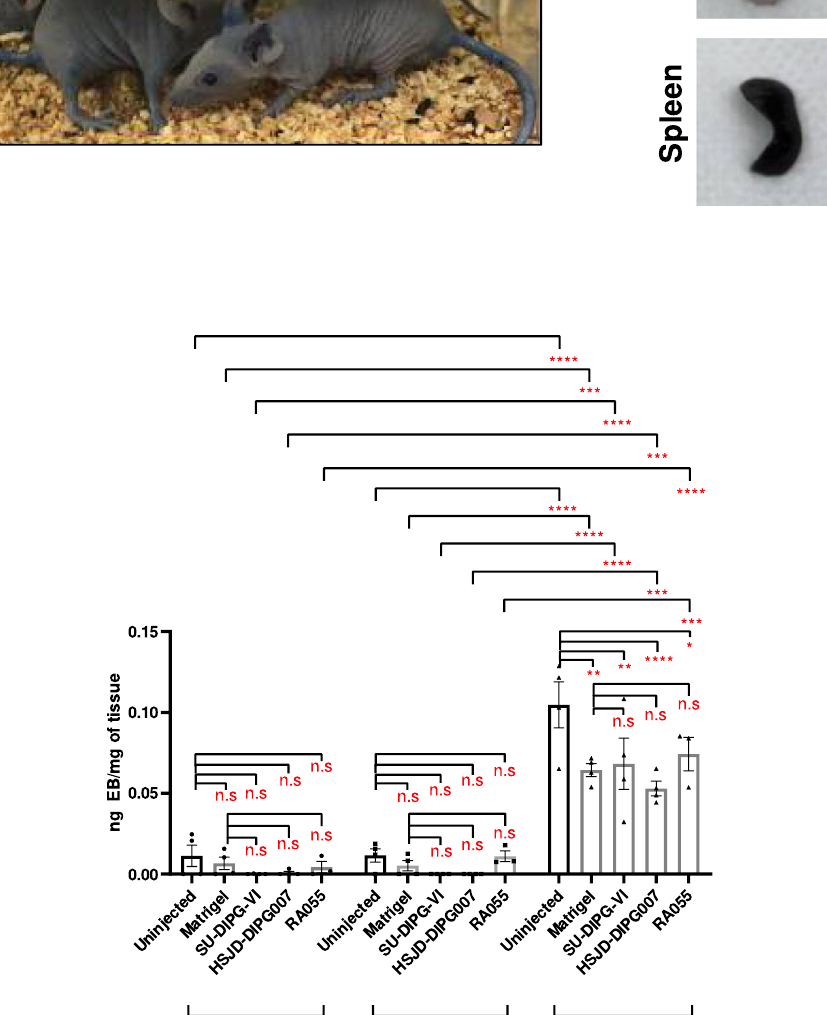
Fig. 5 Evans Blue (EB) extravasation assay in three orthotopic models of DIPG. a Representative images of Balbc/Nude mice injected with Evans Blue dye. b Representative images of brains and spleens harvested from animals intracranially injected with matrigel and RA055 cells. c Brainstem region shows low EB extravasation with no difference among the uninjected, matrigel injected and DIPG injected animals (RA055, SU-DIPGVI, HSJD-DIPG007) and no differences were observed with the tumor free cortical region; Splenic tissue shows higher EB extravasation compared to both brain regions. Data are presented as mean values± SEM of samples collected from three mice in each cohort. * p < 0.05, ** p < 0.01, *** p < 0.001, **** p < 0.0001. Statistical analysis was performed using two-way ANOVA. Spleen-uninjected vs matrigel: p = 0.0012, uninjected vs SU-DIPGVI: p = 0.0040, uninjected vs HSJD-DIPG007: p < 0.0001, uninjected vs RA055: p = 0.04114. Brainstem vs Spleen-uninjected: p < 0.0001, matrigel: p = 0.0001, SU-DIPGVI: p < 0.0001, HSJD-DIPG007: p